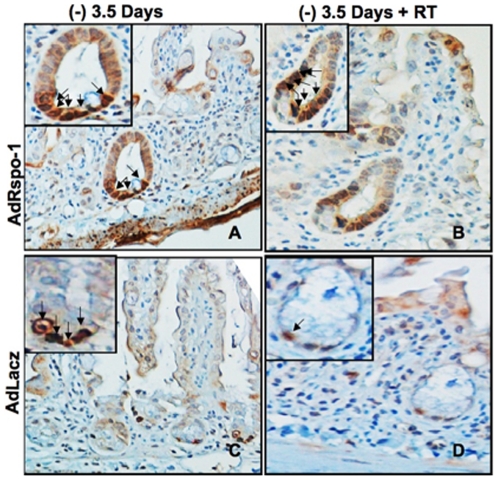
AdRspo1 treatment increases the number of Lgr5-positive intestinal stem cells in irradiated crypts.Immunohistochemical staining of Lgr5 in murine jejunum crypts at 3.5 days prior and after WBI. There was an increase in the number of Lgr5 postive cells at crypt columnar base in AdRspo1 treated cohorts when compared to AdLacZ (magnification 60x; arrows).